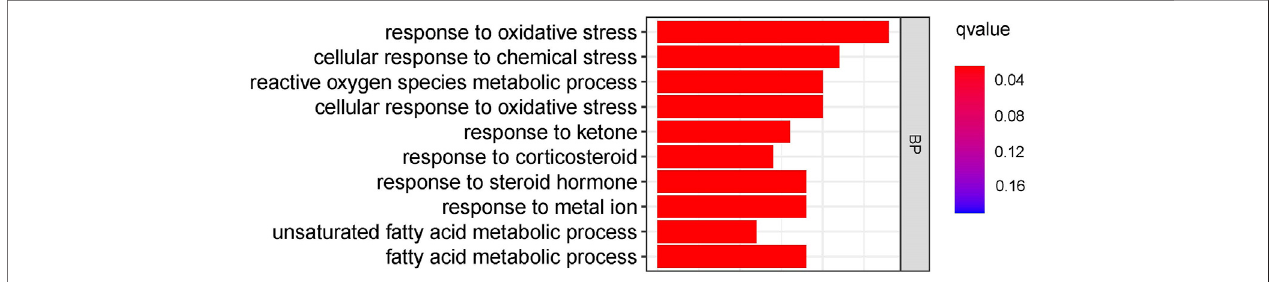
FIGURE 8 | GO enrichment analysis of TLR1-related biological pathways in glioma.